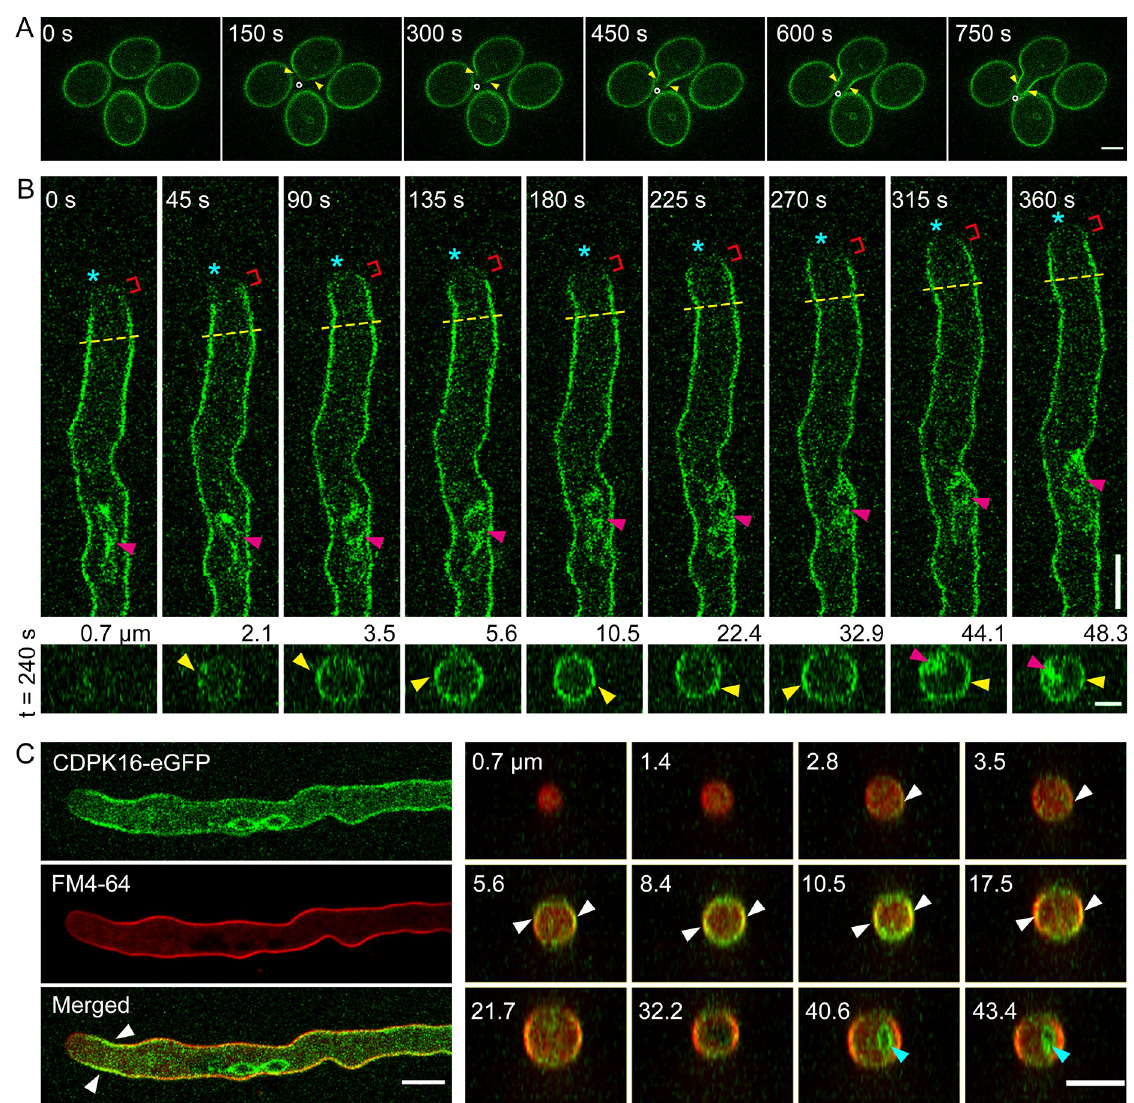
Fig 6. Subcellular localization of CDPK16. ( A ) Intracellular localization of CDPK16-eGFP in pollen grains during germination. Yellow triangles indicate the germination aperture, and white circles indicate the growth direction of the germinating pollen tube. Bar = 10 μ m. ( B ) Intracellular localization of CDPK16-eGFP in pollen tubes. The upper panel is the time-lapse images showing the intracellular localization of CDPK16-eGFP in growing pollen tubes. Bar = 10 μ m. The lower panel shows transverse sections at 240 s. Bar = 5 μ m. Asterisks indicate the growth direction of the pollen tube, and red brackets indicate the apical region with less CDPK16-eGFP signals. The dashed yellow lines indicate the base of the subapical region. The red triangles indicate the membrane of the vegetative nucleus and the yellow triangles indicate the PM. The distance of transverse sections from the tip is indicated above the images. ( C ) Covisualization of CDPK16-eGFP with FM4-64 in the pollen tube. FM4-64 labels the PM but not internal membranes. The right panel shows transverse sections with their distance from the tip indicated in the images. White triangles indicate the PM and blue triangles indicate the membrane of the vegetative nucleus. Bars = 10 μ m. CDPK, calcium-dependent protein kinase; PM, plasma